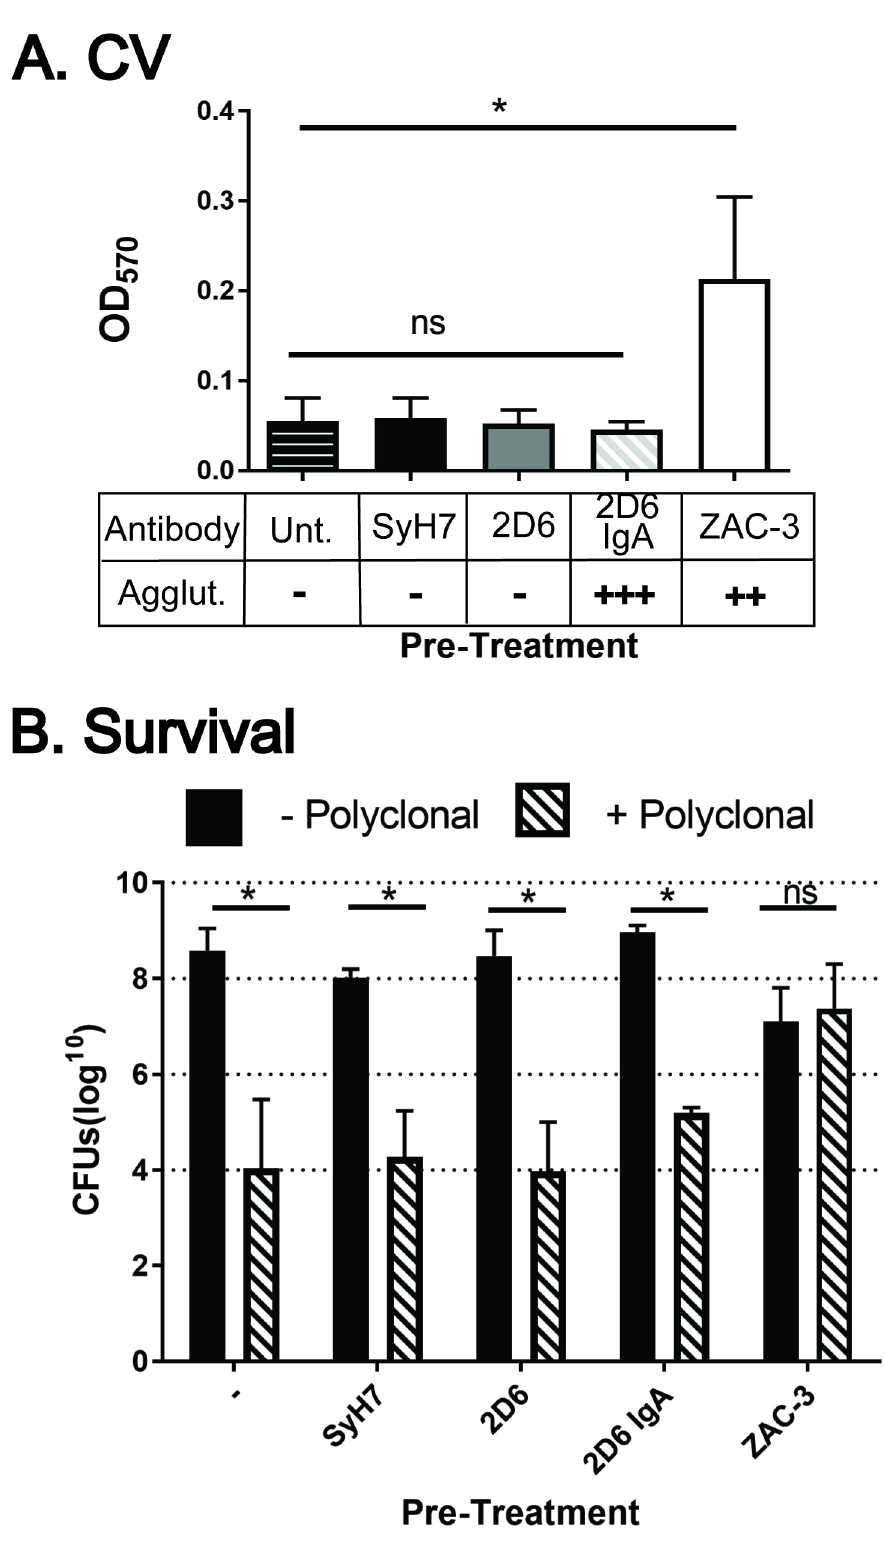
Fig 8. Pre-treatment of V . cholerae with ZAC-3 IgG results in resistance to secondary complement-mediated lysis. (A) CV staining of mid-log phase V . cholerae O395 following treatment for 1 h with SyH7 F(ab’) 2 , 2D6 F(ab’) 2 ,